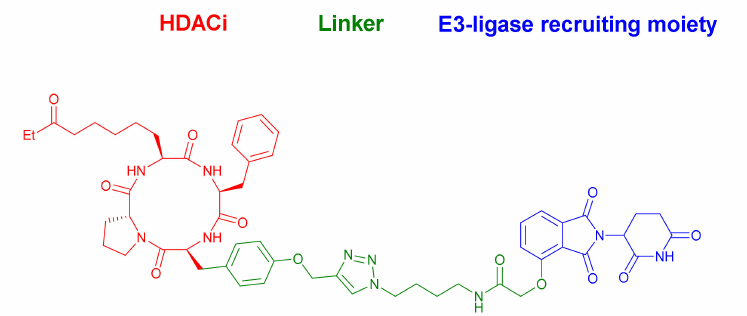
Figure 9. Chemical structure of PROTAC 17 .